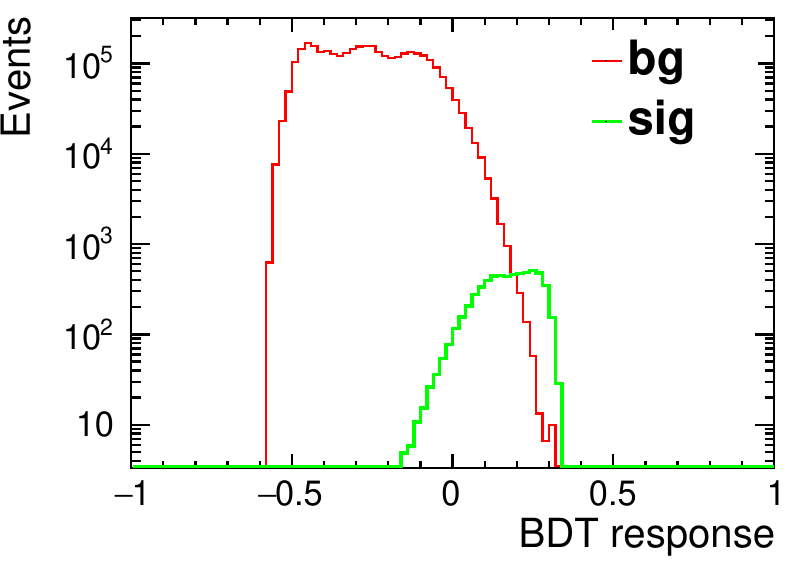
Figure 6. Distribution of the BDT response for the reference scenario (Dirac neutrino, m N = 300 GeV) with muons at ILC500. The red line denotes the background, the green line the